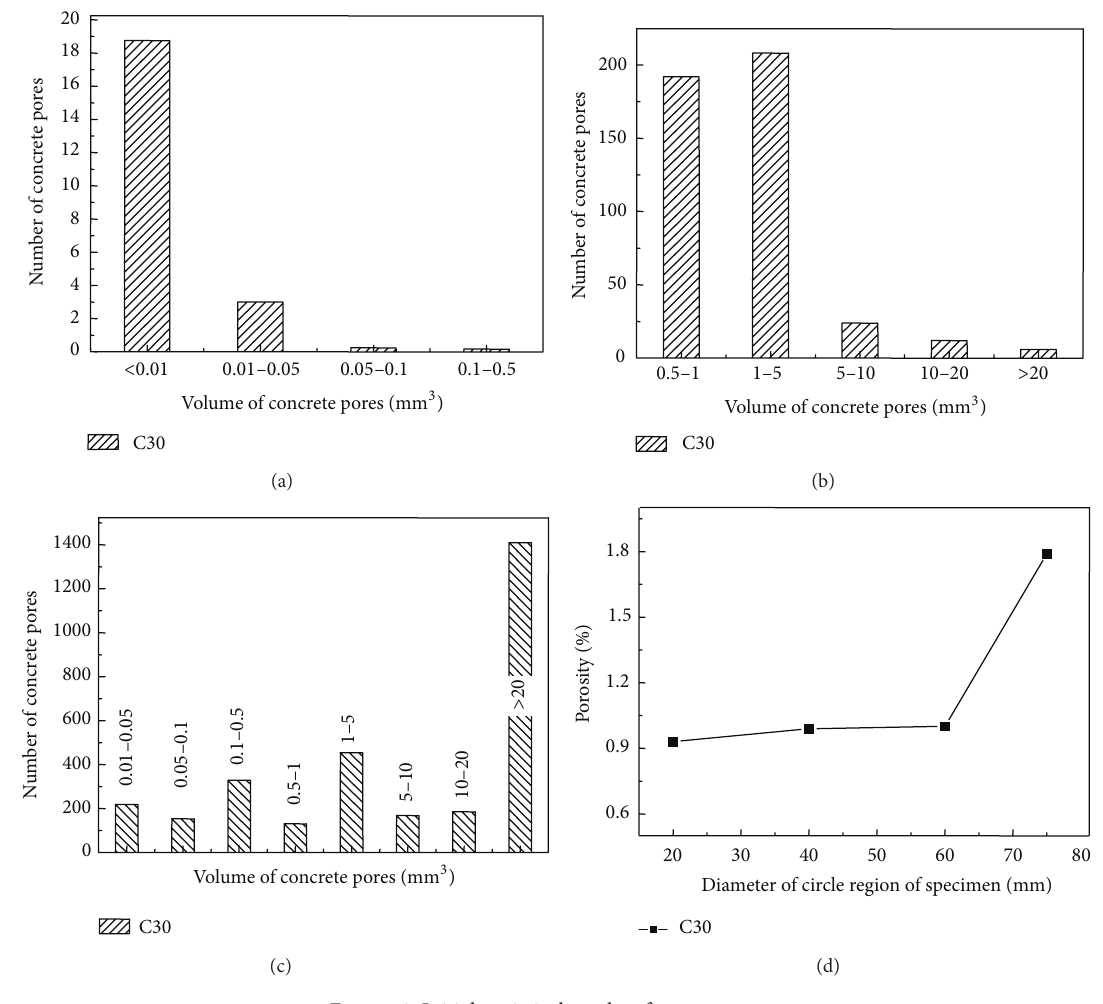
Figure 3: Initial statistical results of concrete